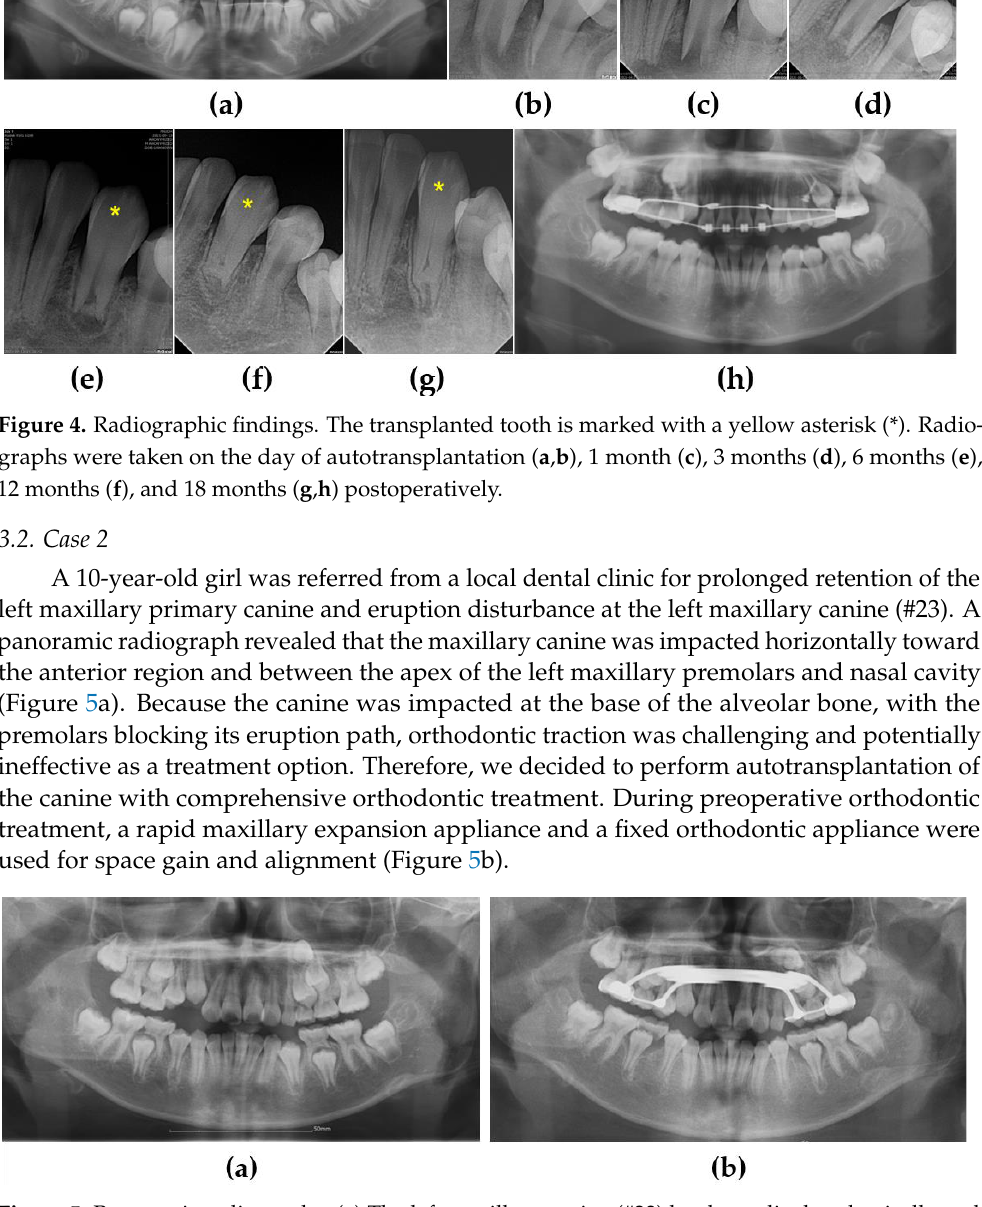
Figure 5. Panoramic radiographs. ( a ) The left maxillary canine (#23) has been displaced apically and horizontally and is facing forward; ( b ) rapid maxillary expansion was performed to create space for the canine.